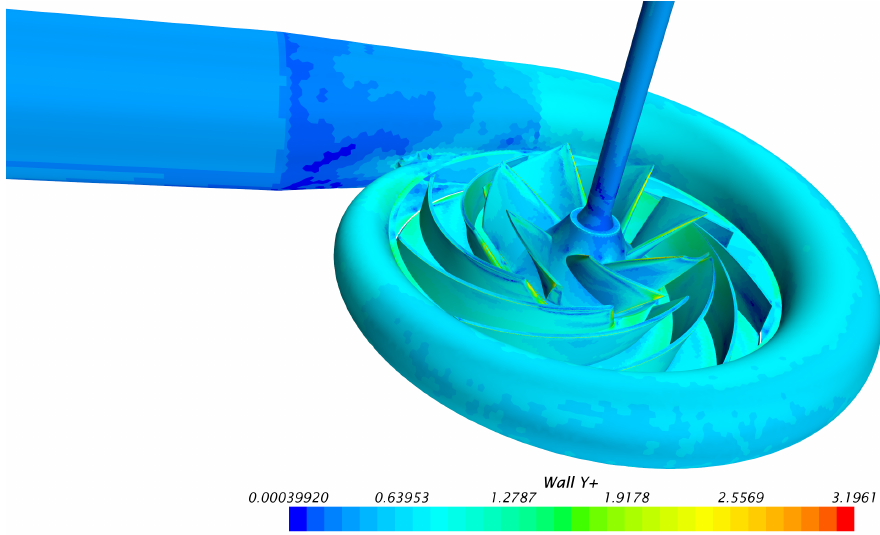
Figure 5. Distribution of Y+ value at BEP ( ˙ m cr = 0.584 kg/s, N1 = − 11k rpm, N2 = 11k